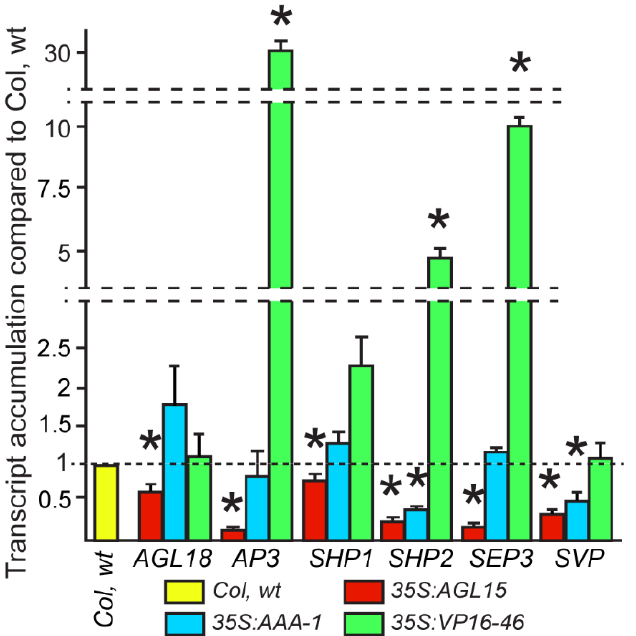
Figure 4. Transcript accumulation from genes encoding select MADS-domain transcription factors in response to the different forms of AGL15. The results shown are the means and standard error of the mean for at least two biological replicates. * indicates significance compared to Col wt at p < 0.05 as assessed with a Student’s t -test. NS. Please note the breaks in the y-axis. Col wt is set to 1 for all comparisons.